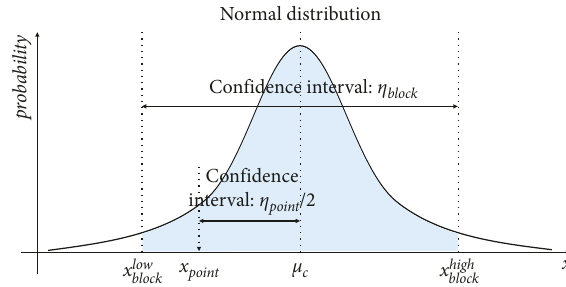
Figure 7: Confidence interval in normal